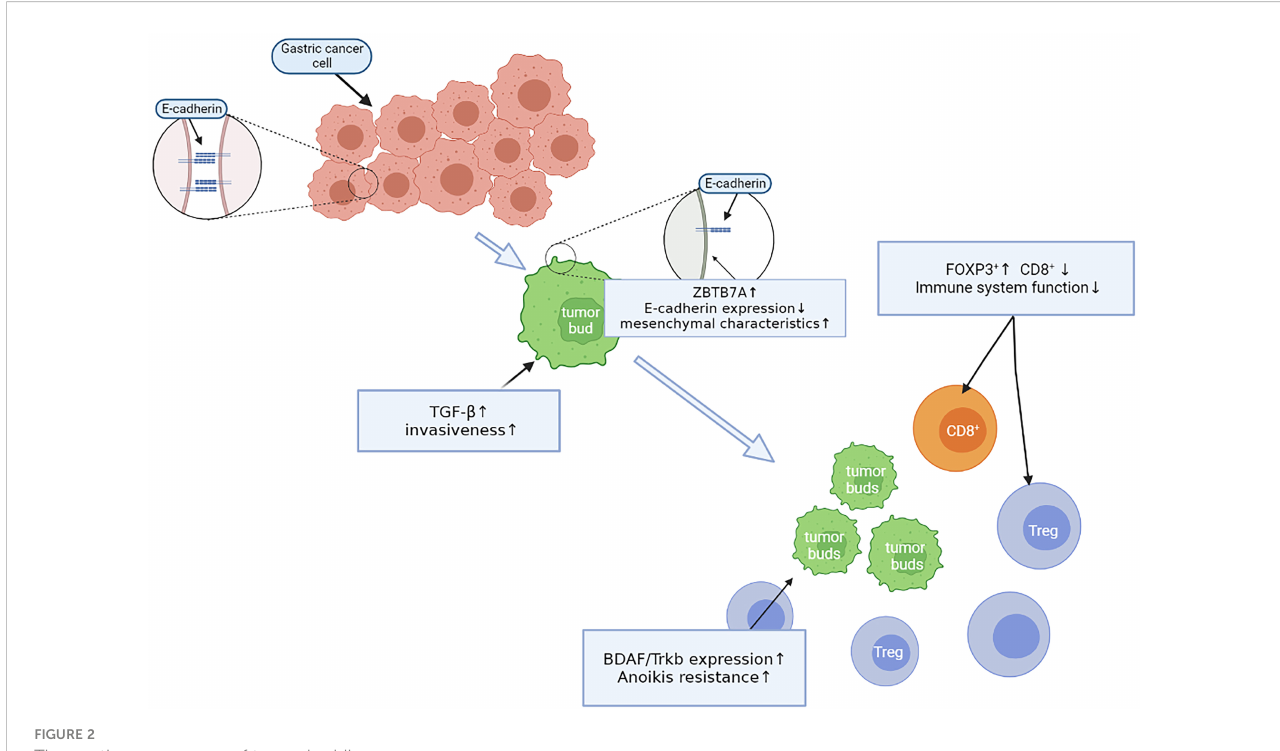
FIGURE 2 The continuous process of tumor